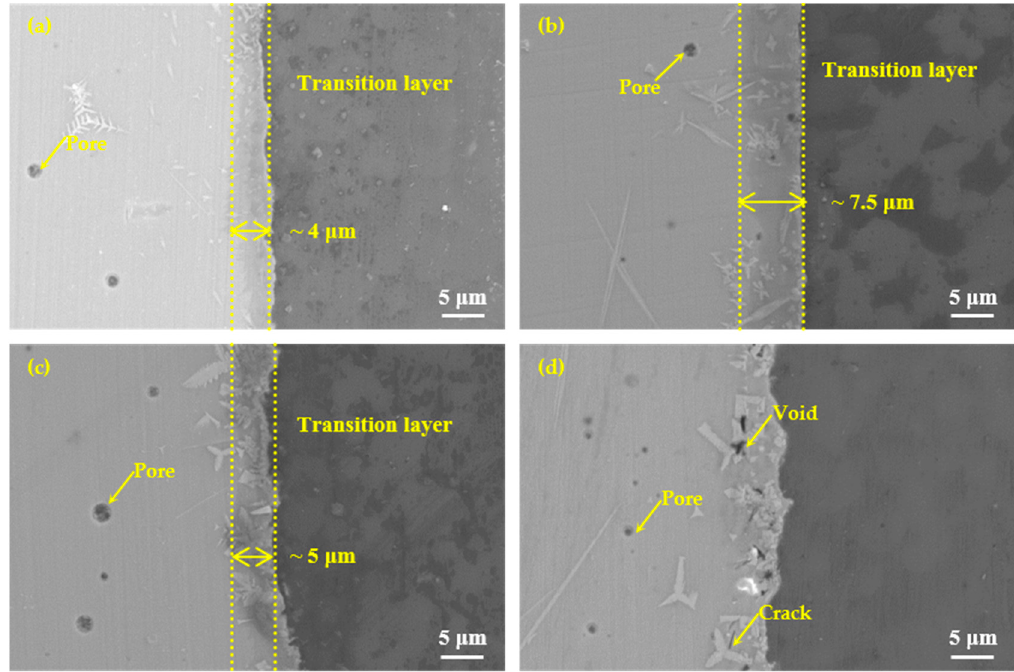
Figure 13. Microstructure evolution of the joints at the brazing temperature 495 °C for different brazing times: ( a ) 10 min; ( b ) 20 min; ( c ) 30 min and ( d ) 40 min.